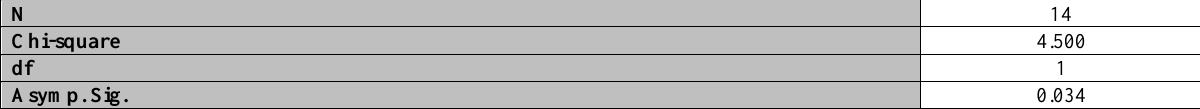
Table 9. Delays in Shipments and Moving Cargo Processes (Friedman)